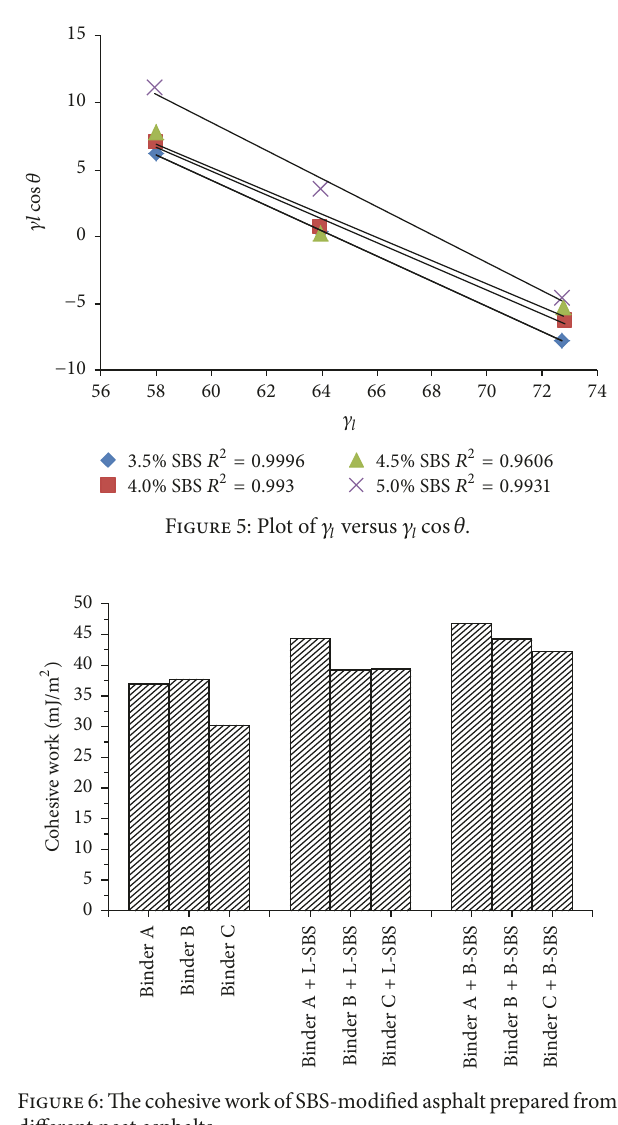
Figure6:ThecohesiveworkofSBS-modifiedasphaltpreparedfrom different neat asphalts.